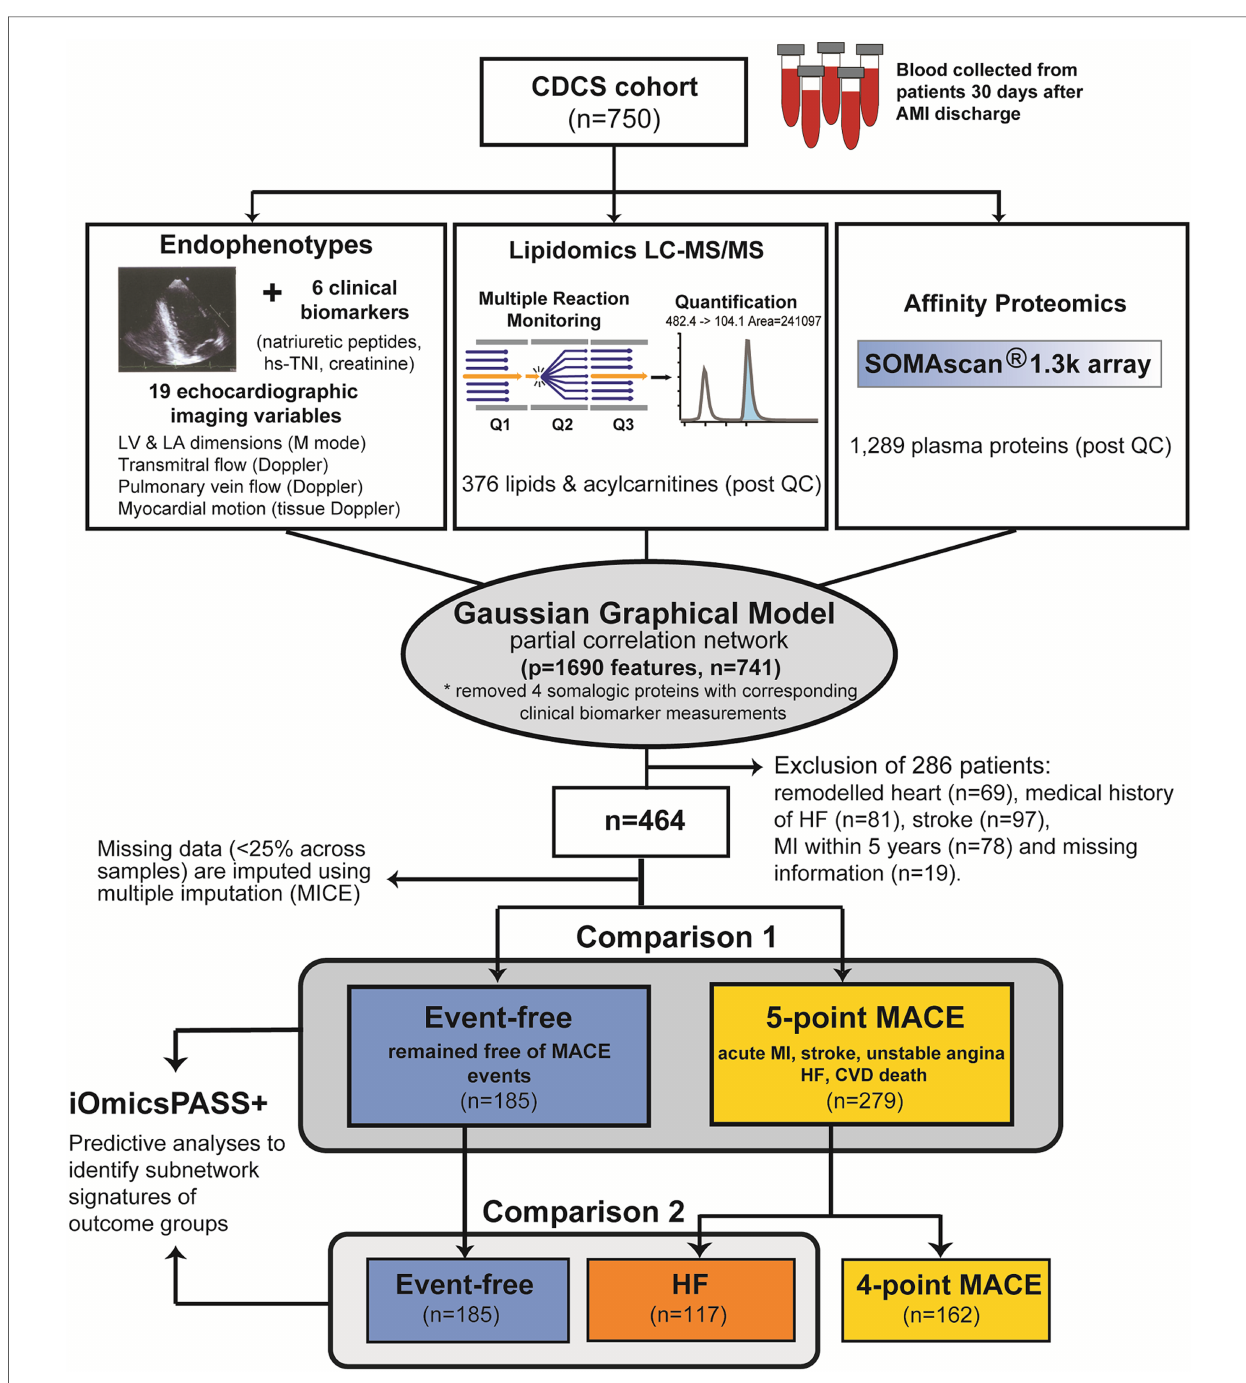
FIGURE 1 Analysis work fl ow applied to the CDCS cohort. The background network re fl ecting the conditional dependence structure among the four data types was inferred using graphical LASSO. From the network, subnetwork signatures of secondary MACE and HF were obtained using the training dataset (CDCS) using 10-fold cross validation for choosing the optimal regularization